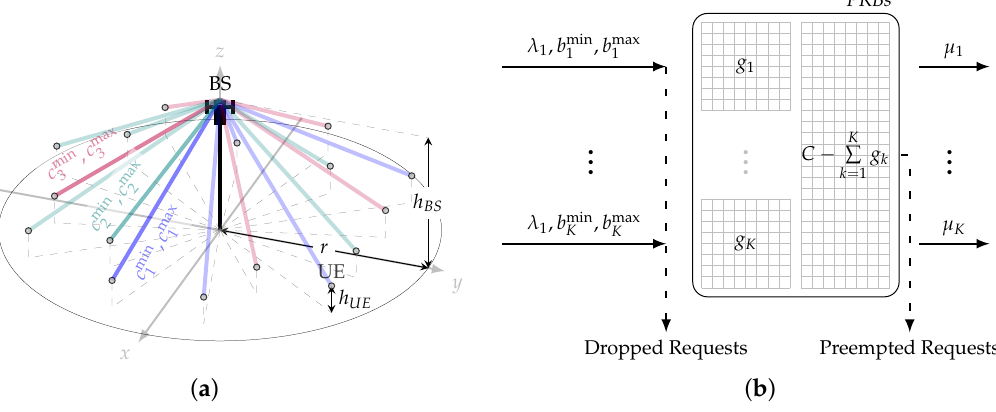
Figure 1. The considered system model and its formalization in terms of a queueing system: ( a ) system model, ( b ) queueing